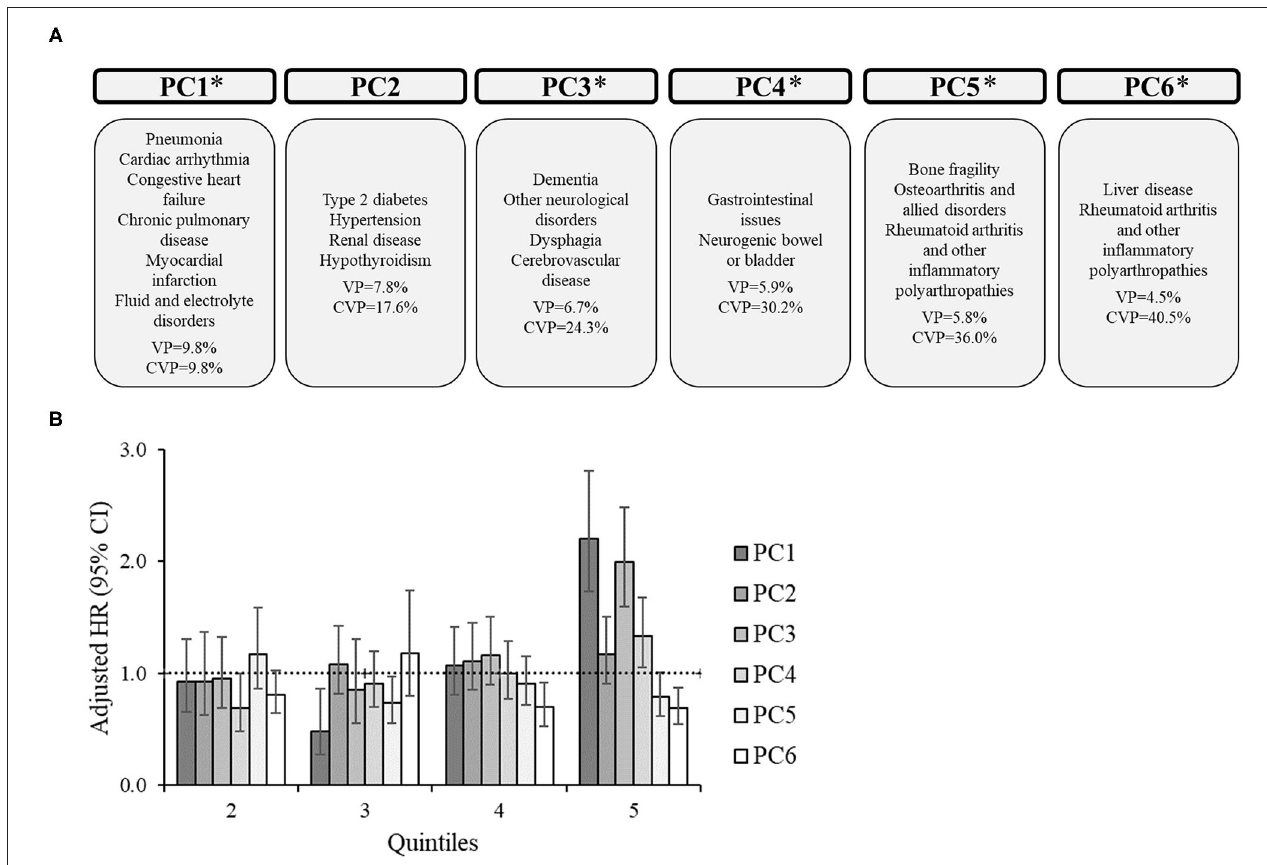
FIGURE 2 | Principal component analysis among 7,542 adults with cerebral palsy without co-occurring epilepsy and intellectual disabilities. (A) Principal components (PC) represent the comorbidity combinations in order of the amount of variance percent (VP) explained and the cumulative VP (CVP) explained. * P < 0.05 for the association of that PC with 2-year mortality. (B) The association between each PC with 2-year mortality after PC scores were transformed into quintiles to facilitate comparisons across PCs (reference: lowest quintile). The bars represent the hazard ratio (HR) and the vertical lines represent the 95% confidence interval (CI) for 2-year mortality after adjusting for all PCs, age, sex, race, and U.S. region of residence. The dotted horizontal line represents a HR of 1.0. If the 95% CI crosses the dotted line, the association is not statistically significant at P =